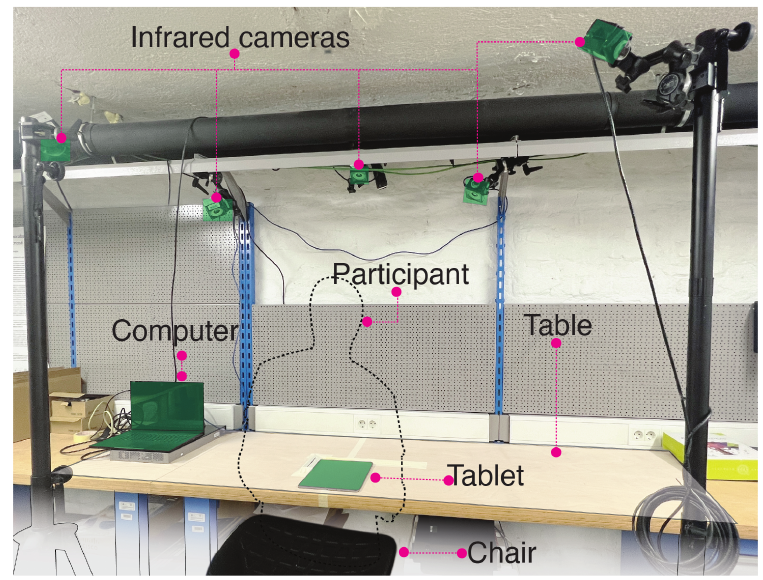
Figure 3. Testing rig used in the three